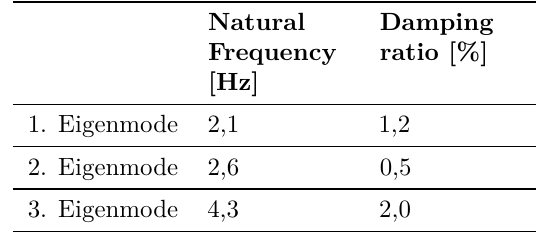
Table 4. Natural frequencies and damping ratios of the y-direction of the